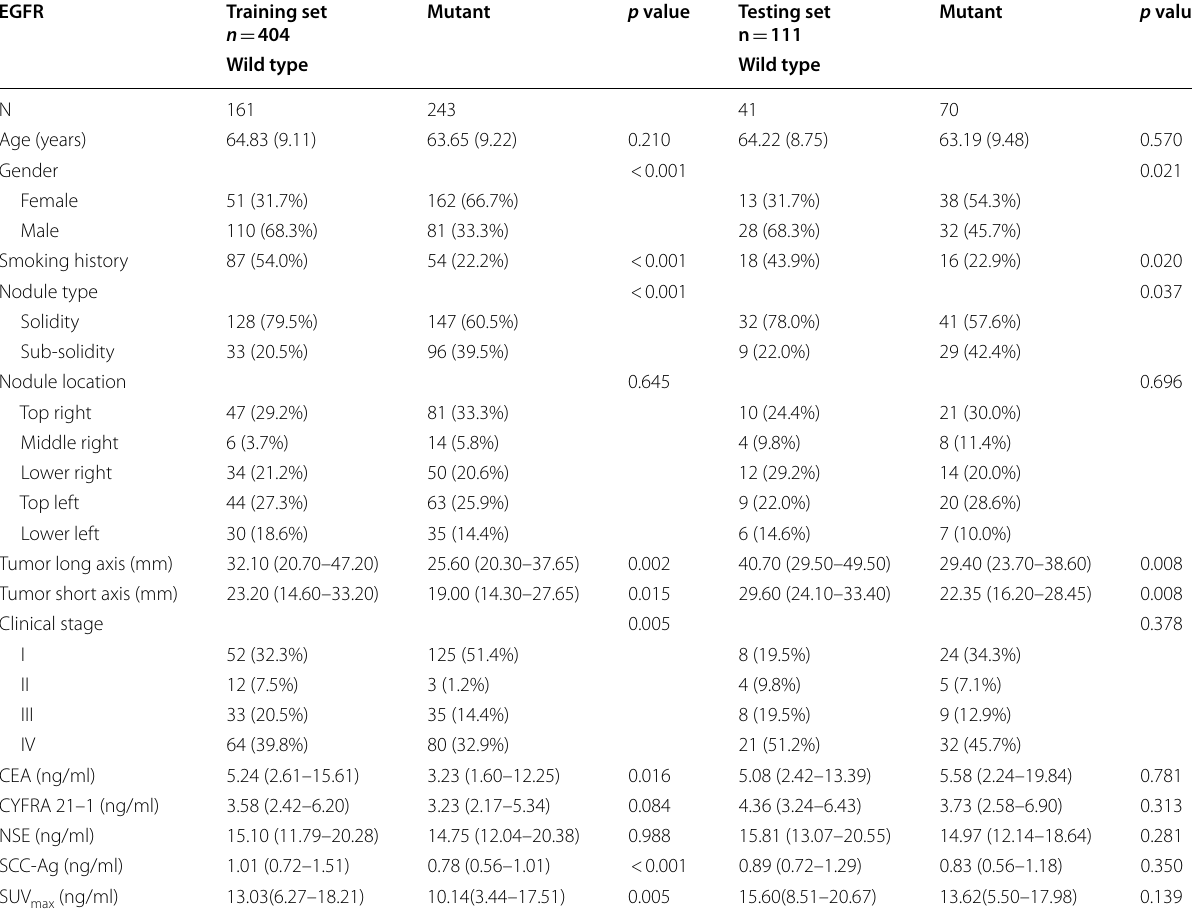
Table 1 Clinical characteristics of patients with different EGFR mutation status in training set and testing set